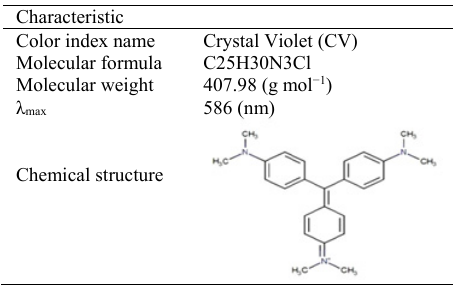
Table 1. characteristics of the investigated dye.